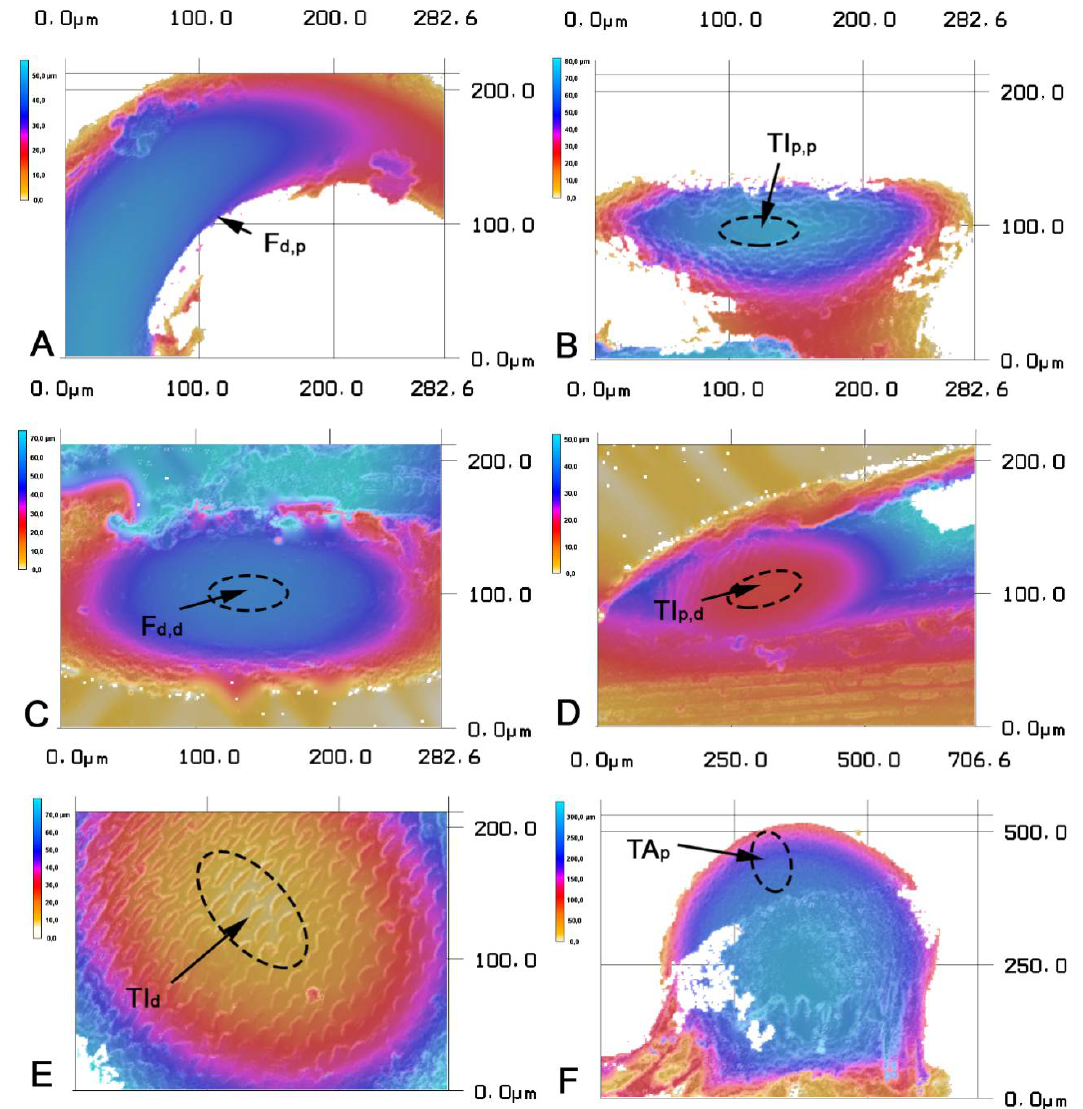
Figure 3. Confocal laser scanning microscopy rainbow-colored height profile images of the contacting surfaces in ( A – D ) the femur–tibia and ( E , F ) the tibia–tarsus leg joints of P. marginata . Dashed ellipses indicate the position of the condyle. F d,p : the distal end of the femur, the proximal condyle; TI p,p : the proximal end of the tibia, the proximal condyle; F d,d : the distal end of the femur, the distal condyle; TI p,d : the proximal end of the tibia, the distal condyle; TI d : the distal end and the condyle of the tibia; TA p : the proximal end and the condyle of the tarsus.